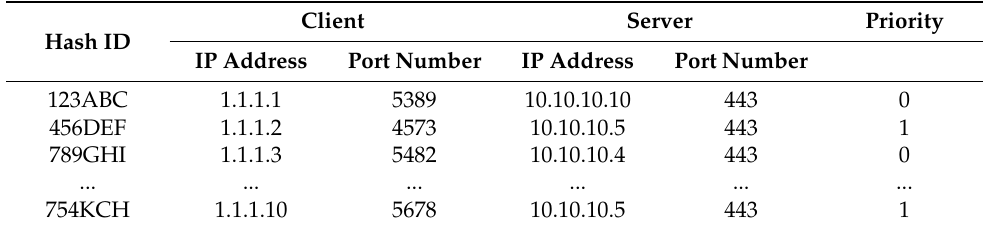
Table 2. Connection management table by Hash